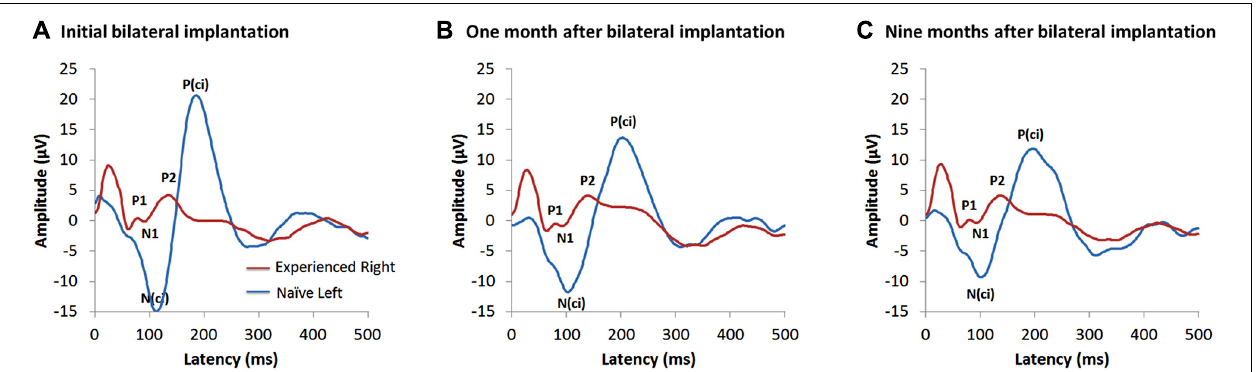
deprived left side (naïve side; blue waveform). Cortical responses evoked from both implants are shown at: (A) the first day of activation of the second implanted ear (Jiwani etal., 2013b), (B) one month after bilateral implantation (Jiwani etal., 2013c) and (C) 9 months following bilateral cochlear implant experience (Jiwani etal.,